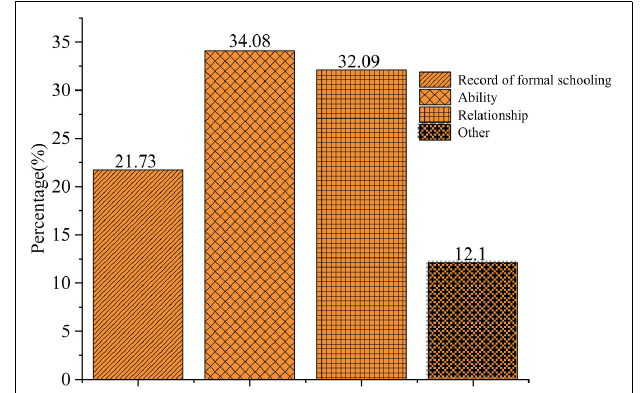
FIGURE 2 | Essential elements for the entrepreneurial process.